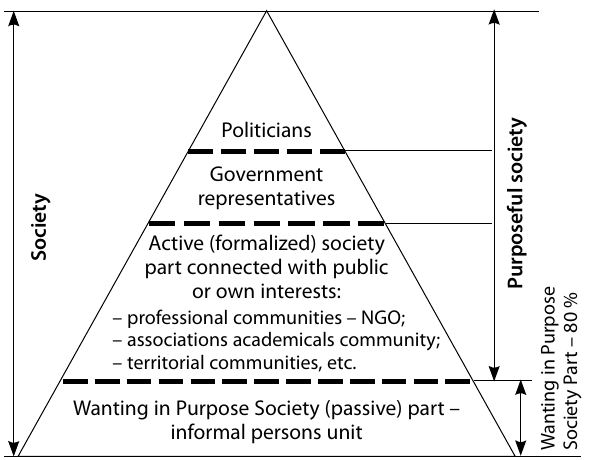
Fig. 1. Society model of cognition